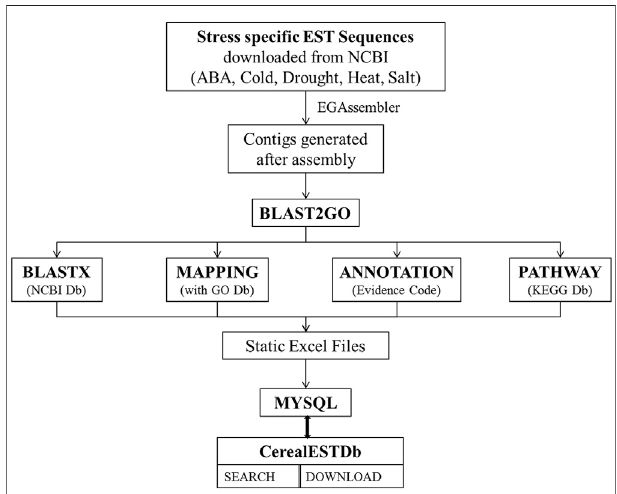
FIGURE 2 | Schematic illustration of the process of development of CerealESTDb.